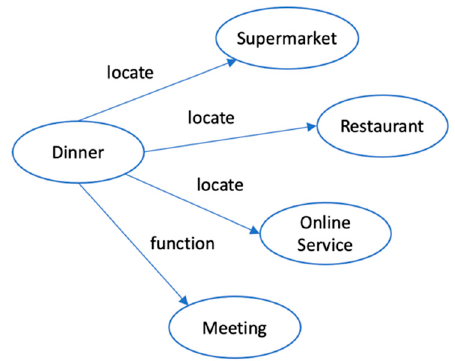
Figure 6. The part of knowledge graph in the case.